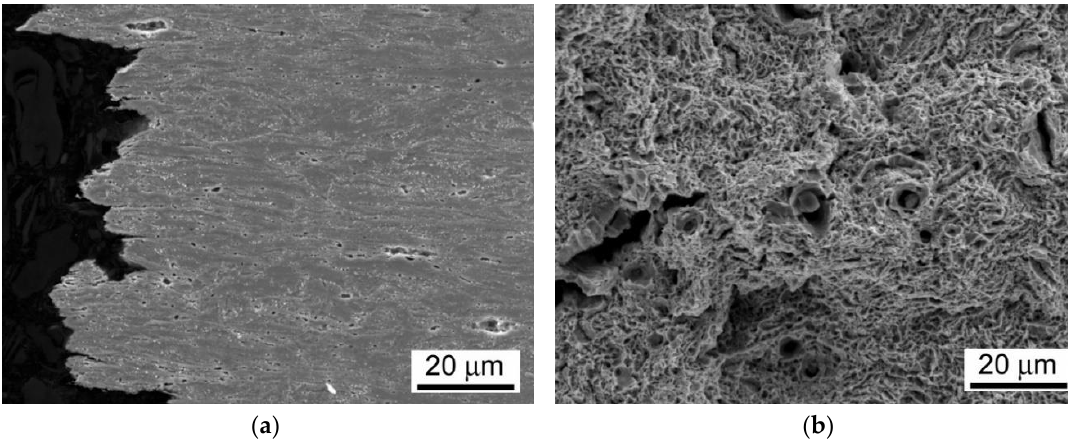
Figure 13. Fracture analysis of hydrogen-free T92/T92 weldment initially processed by the PWHT-1 and subsequently ruptured in SC-HAZ after the room-temperature tensile test: ( a ) fracture path and microstructure beneath the fracture; ( b ) fracture surface showing pure ductile dimple tearing.